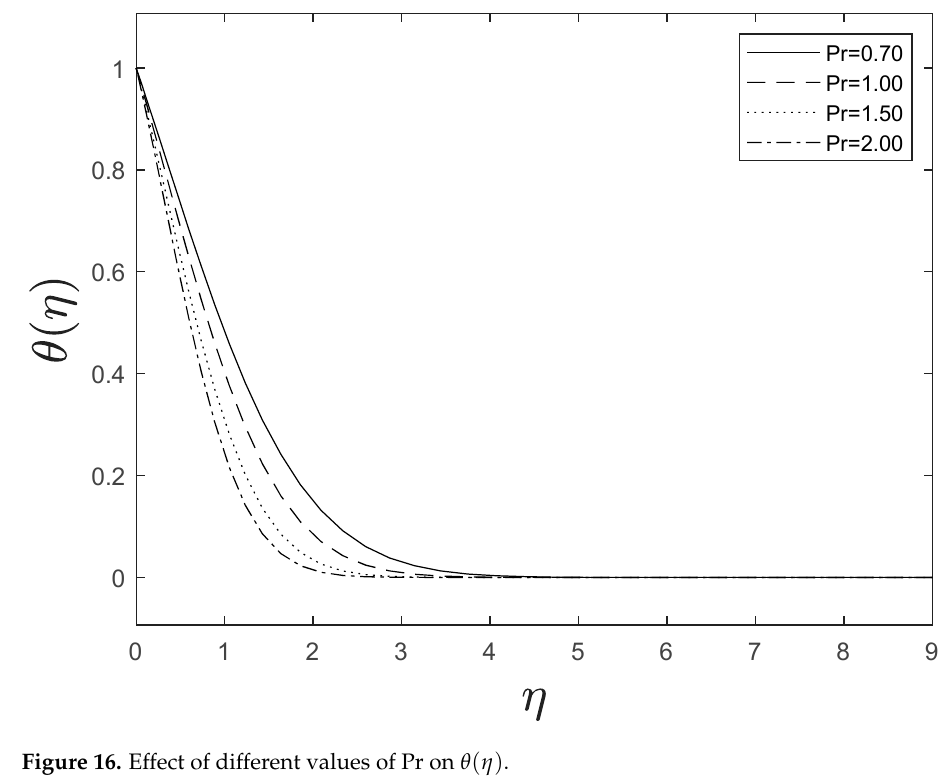
Figure 16. Effect of different values of Pr on θ ( η ) .